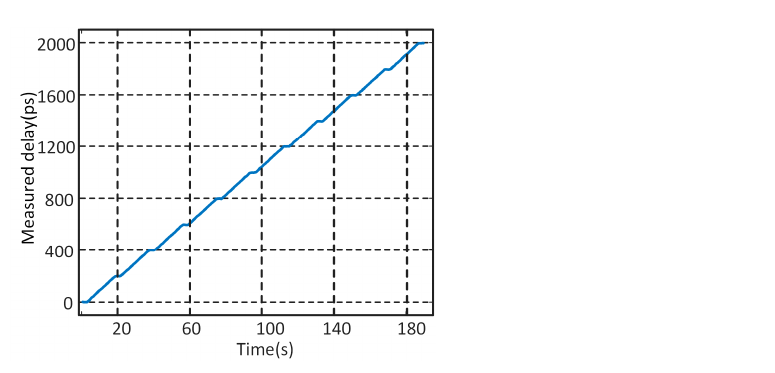
Figure 10. The measurement FTD of a 15 km fi ber spool and a variable optical delay line.